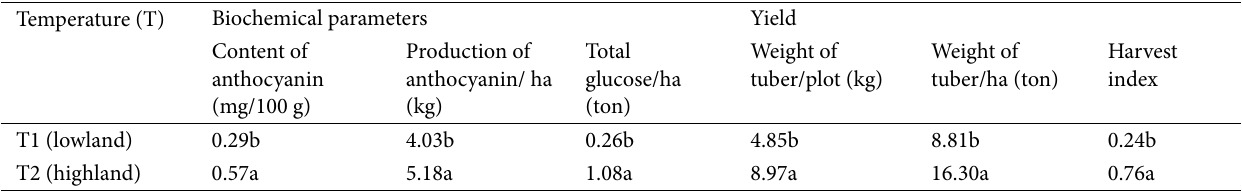
Table 4 Differences in selected biochemical parameters and yield caused by temperature at harvest.